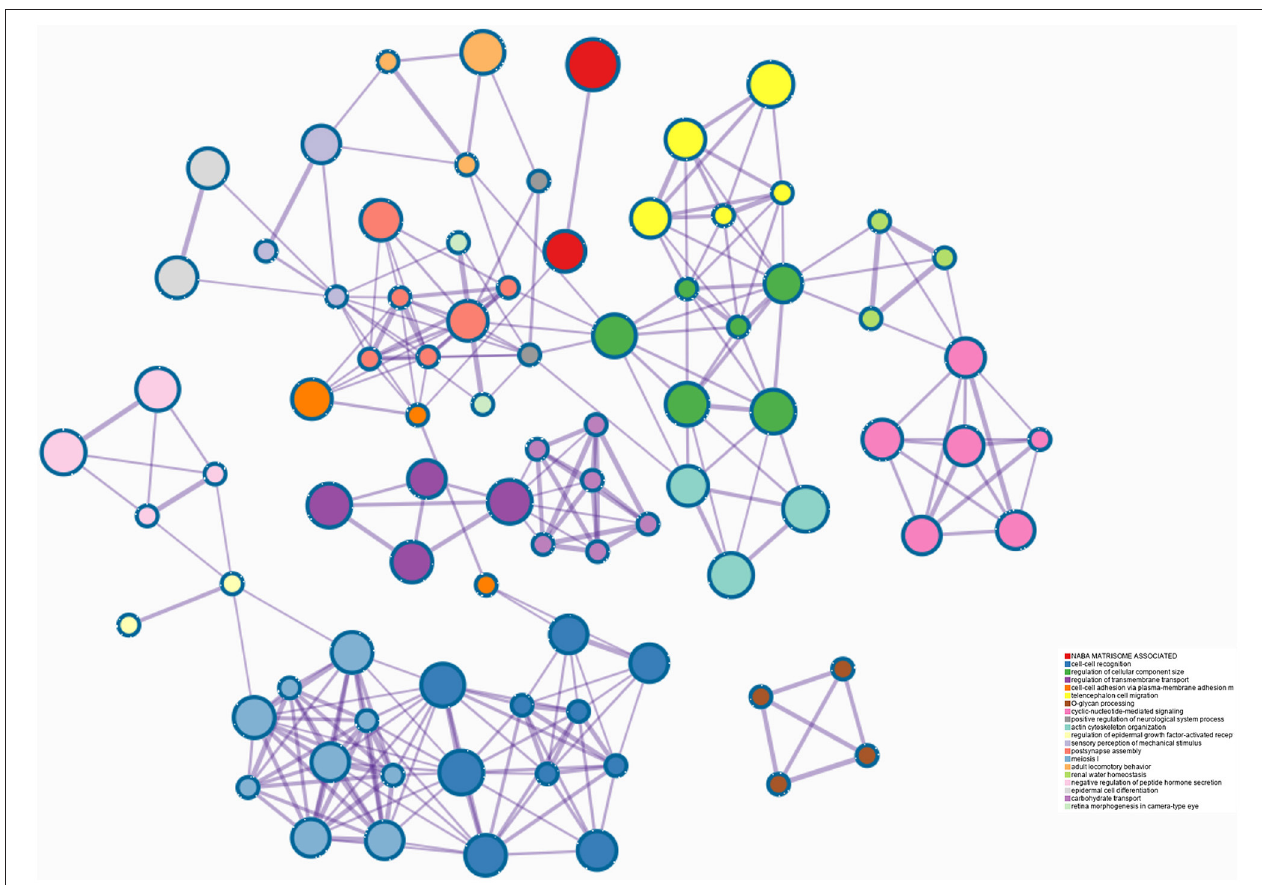
FIGURE 4 | Enrichment analysis using the Meatscape.